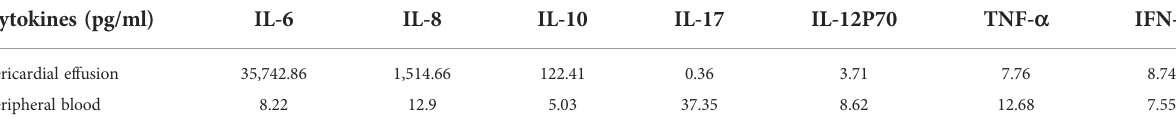
TABLE 1 Cytokines in pericardial effusion and peripheral blood. Cytokines (pg/ml)